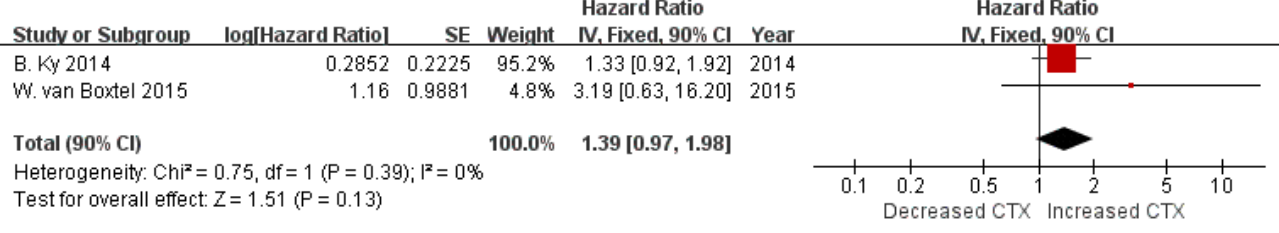
Figure 4. Cancer-therapy-related cardiotoxicity as measured by a standardized left ventricular ejec- tion fraction decrease with no considerable Galectin-3 change. Parallelogram boxes for hazard ratio, and horizontal lines represent 90% confidence interval (CI) [15,19].